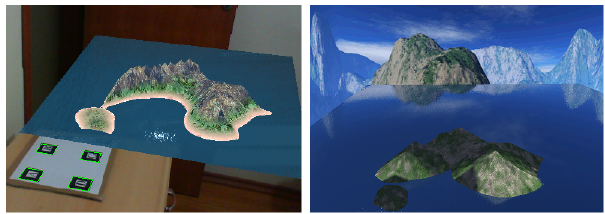
Fig. 17. Final terrain to the left and the virtual environment generated based on it to the right.